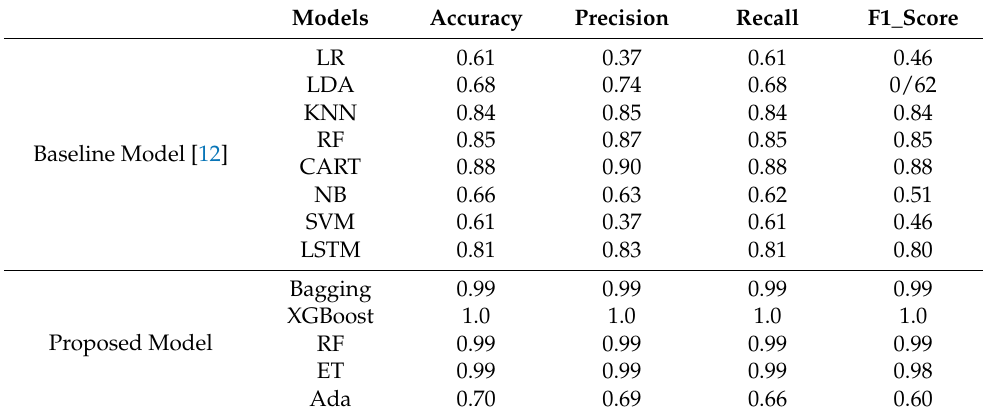
Table 12. The proposed model is compared with the baseline model.